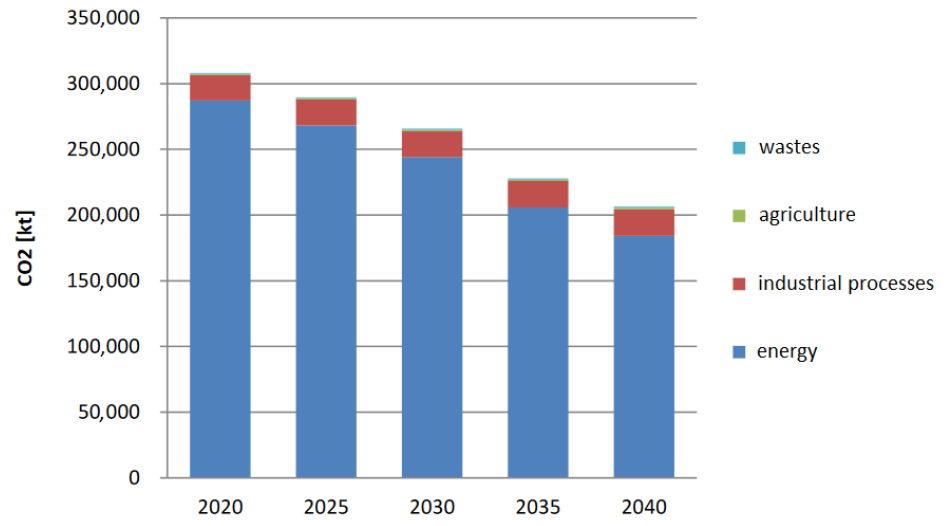
Figure 2. Reduction of CO 2 emission by sectors (without LULUCF) to 2040 (source: [21]). As potentially low- or zero-carbon use of coal would allow partial continued use of and carbon sequestration (CCS) or carbon utilisation (CCU) is being considered, but will depend on economic viability and carbon dioxide emission allowance prices.